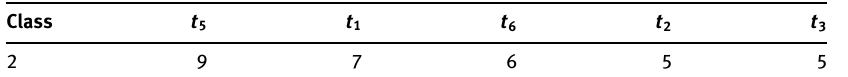
Table 7: Selecting N ′ = 5 for Class